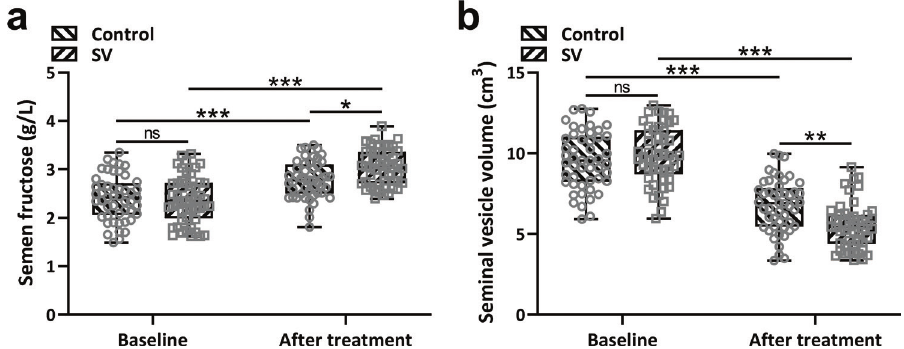
Fig. 3 . Comparisons of semen fructose concentration (a) and seminal vesicle volume (b) between the two groups before and after treatment. N = 49 for each group. Data were shown with box plot. * P < 0.05, ** P < 0.01, *** P < 0.001, and ns means no significance. Two-way ANOVA followed Turkey’s multiple comparisons